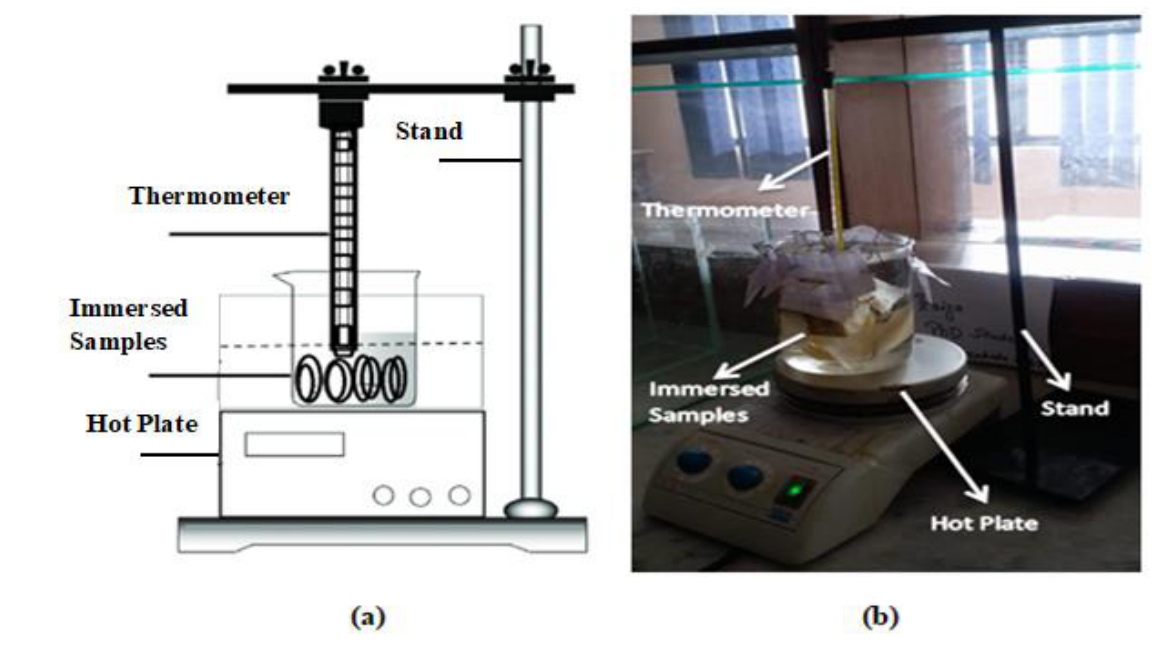
Figure 3. Long-term aging setup ( a ) and schematic diagram ( b ).